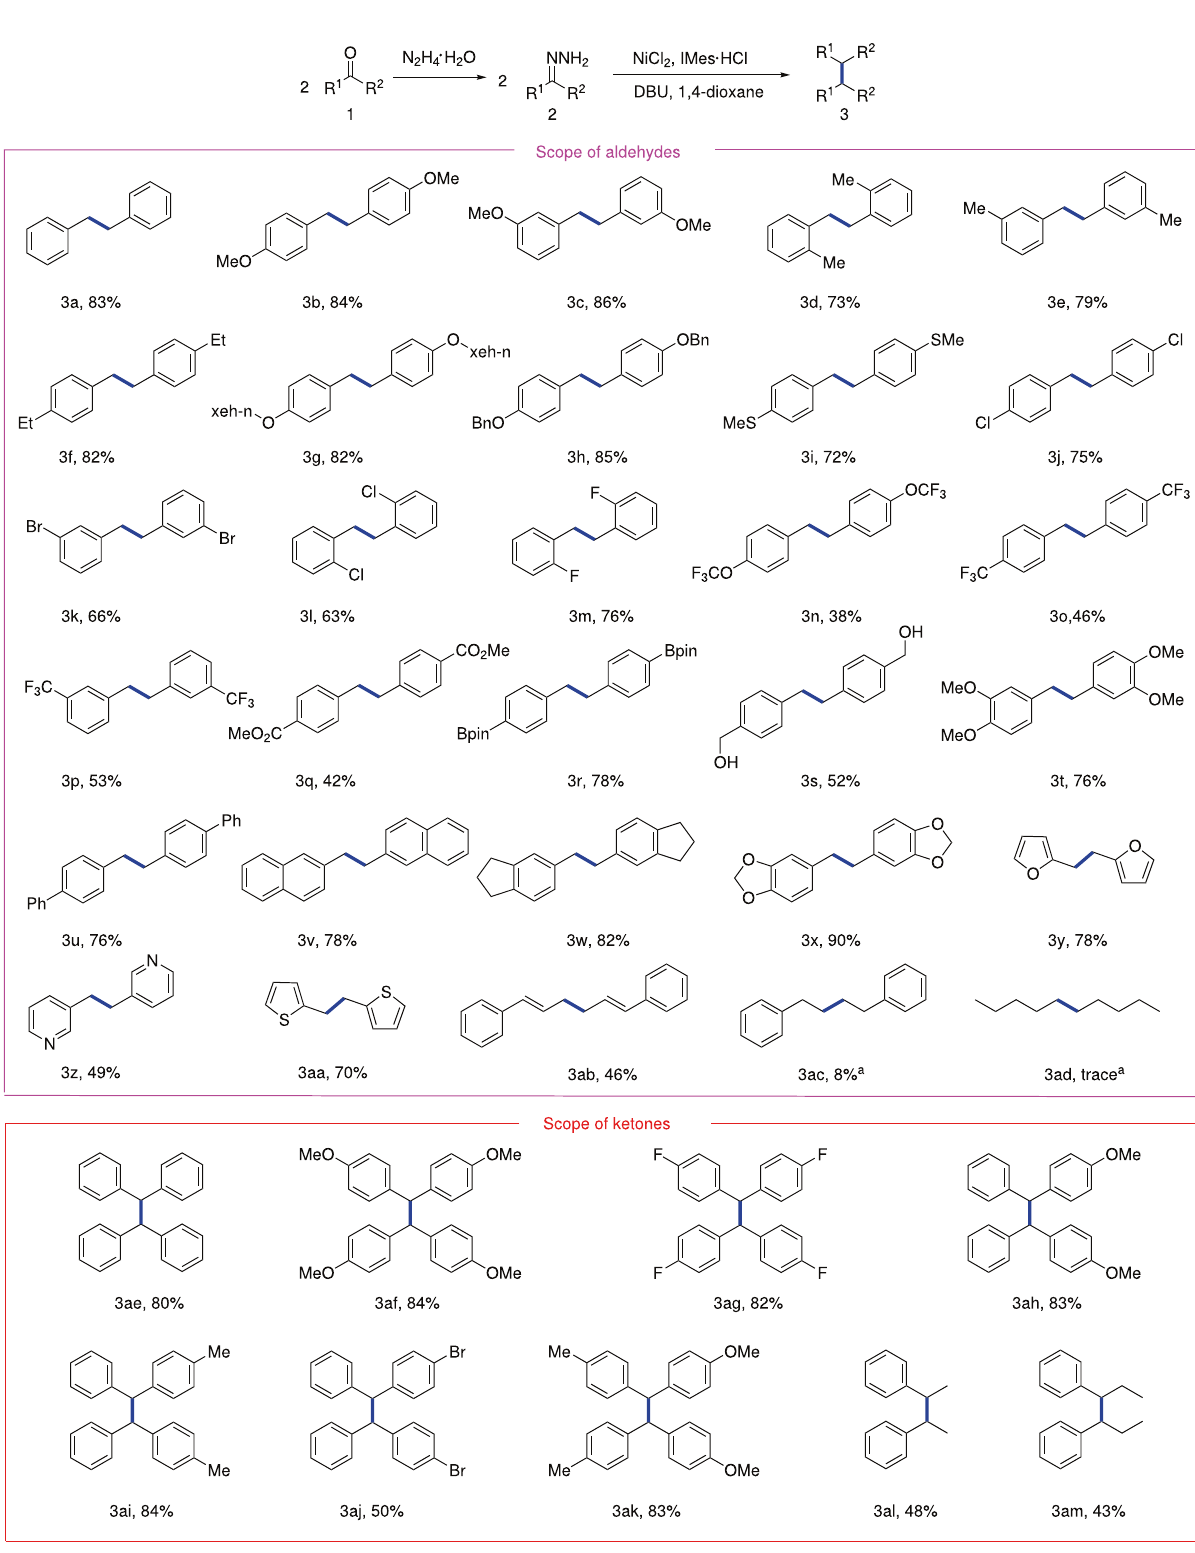
Fig. 2 Substrate scope of the homo-coupling reaction. General conditions: 2 (2×0.1mmol), NiCl 2 (0.03mmol, 30mol%), IMes ∙ HCl (0.03mmol, 30mol%), DBU (0.22mmol, 2.2 equiv) and 1,4-dioxane (1.0mL) at 100°C for 24h under an argon atmosphere, isolated yields. a Detected by